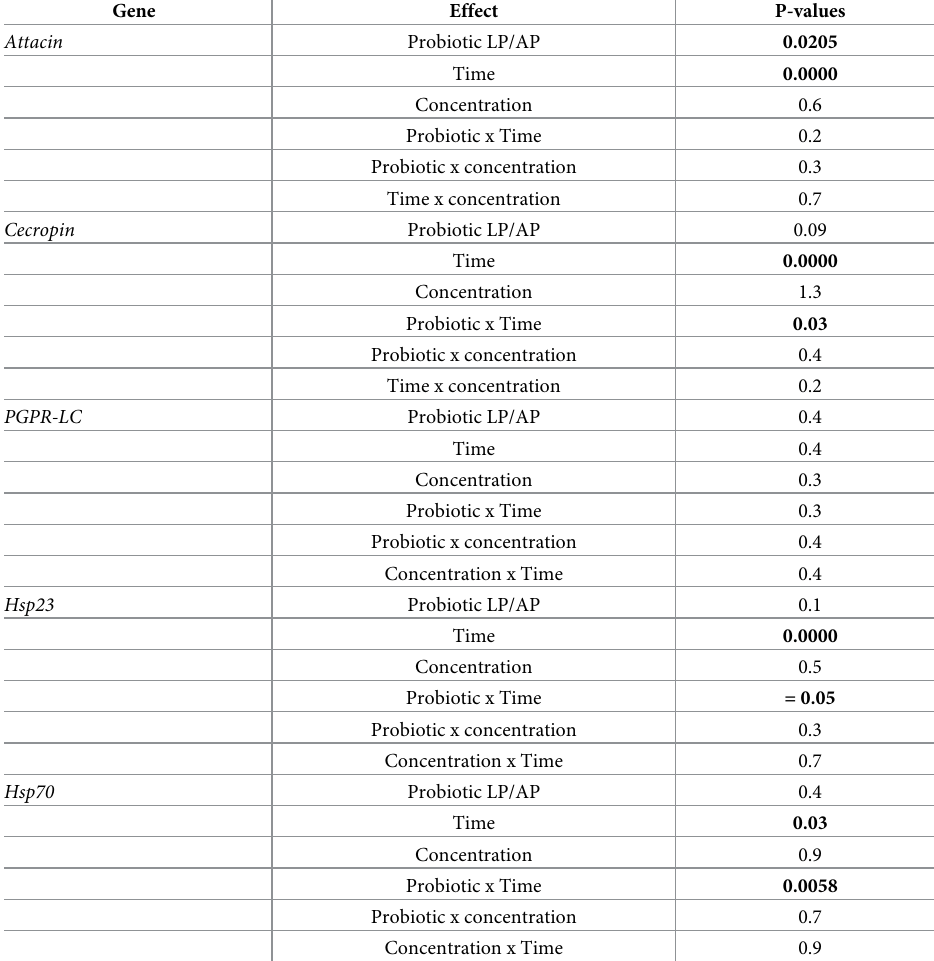
Fig 3. Relative level of expression of attacin (A), cecropin (B), PGRP-LC (C), hsp23 (D), hsp70 (E) genes determined by qRT-PCR. Line graphs showing relative genes expression as means SD of log fold changes from pupae 0 h, pupae 18 h, adult male 72 h and adult male 168 h age supplemented with live (LP) and autoclaved (AP) probiotic compared to the non- probiotic. The mRNA level of G6PDH and GAPDH2 transcripts were used to normalize the expression level of candidate genes. Differences in mRNA expression level were analyzed using Multifactor ANOVA for each gene followed by LSD to discriminate means at the 95% confidence level. Standard errors across replicate trials are plotted in the graph. Symbol ( � ) indicates for each gene statistical differences (P � 0.05) observed with untreated control. Different letters indicate statistical difference (P � 0.05) between means. https://doi.org/10.1371/journal.pone.0257097.g003 obtained averages for sterile males are higher than the acceptable means specified for produced fruit flies for SIT programs (7.5 mg) [60]. 3.3.2. Emergence. There was a significant difference between all the treatments (F = 6,14 11,34; P = 0,001; F = 3.57, P = 0.01), for both sterile males and females. The highest percent- 6,14 age of emergence recorded in sterile males and females was obtained from the diet enriched with AP bacteria to a concentration of 10 9 CFU/ml (83.00 ± 0.56% and 84.59 ± 5.32%). On the other hand, the lowest percentage of emergence for sterile males and for females was recorded